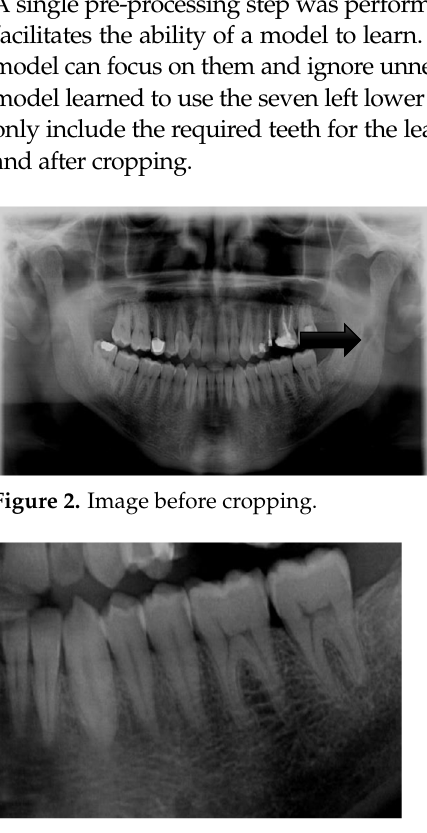
Figure 3. Image after cropping.